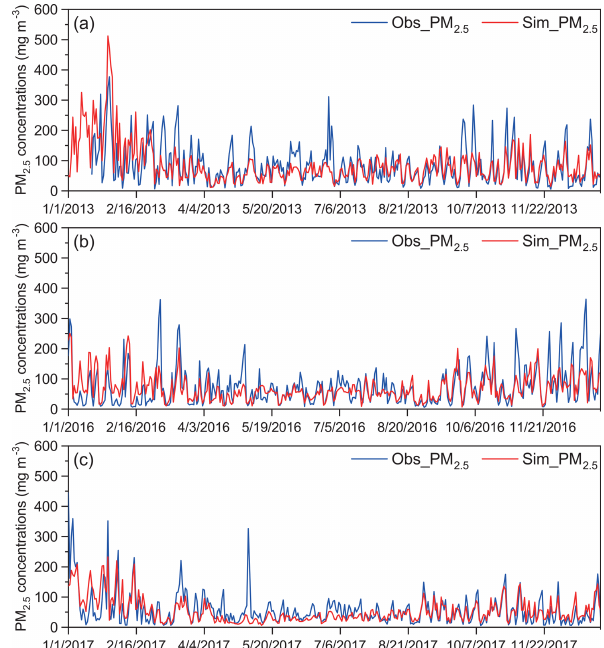
Figure 2. Comparison of observed (blue) and CMAQ-simulated (red) daily mean PM 2 . 5 concentrations over Beijing in 2013 (a) , 2016 (b) , and 2017 (c) . Observation data were obtained and aver- aged from 12 national observation stations in Beijing. Simulated concentrations were extracted from the grids corresponding to the station